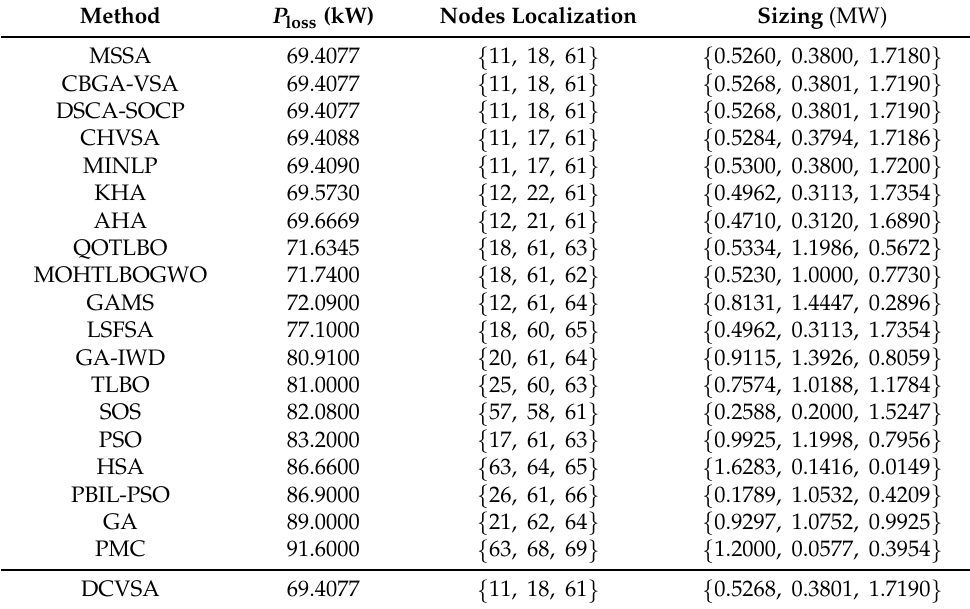
Table 4. Location and sizing of PV systems in the 69-node